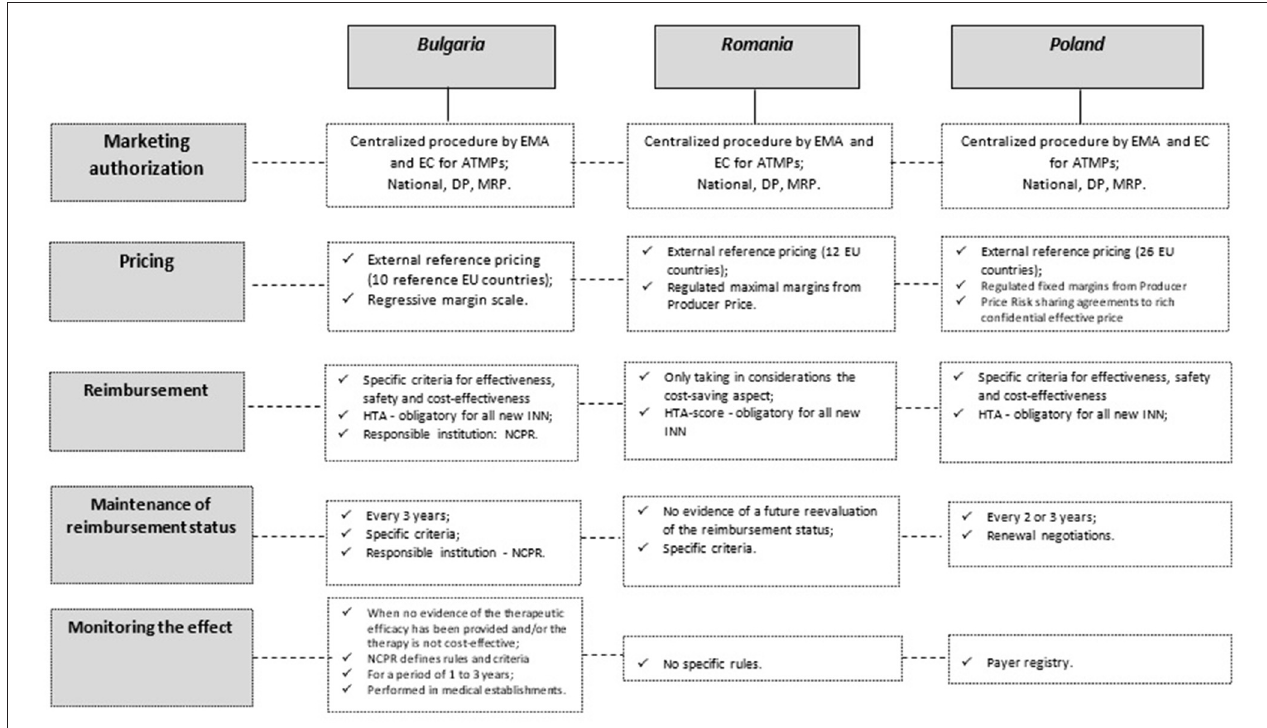
FIGURE 1 | Schematic view of the medicines access to the market in Bulgaria, Romania and Poland. ATMPs, Advanced therapy medicinal products; DP, Decentralized procedure; EC, European Commission; EMA, European Medicines Agency; EU, European Union; HTA, Health Technology Assessment;